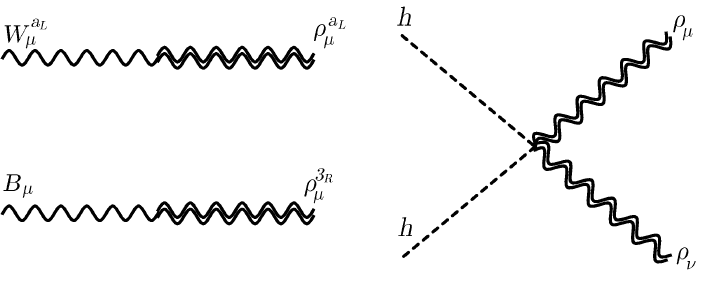
Figure 2 . Gauge bosons vertices derived assuming hidden local symmetry in the L int .